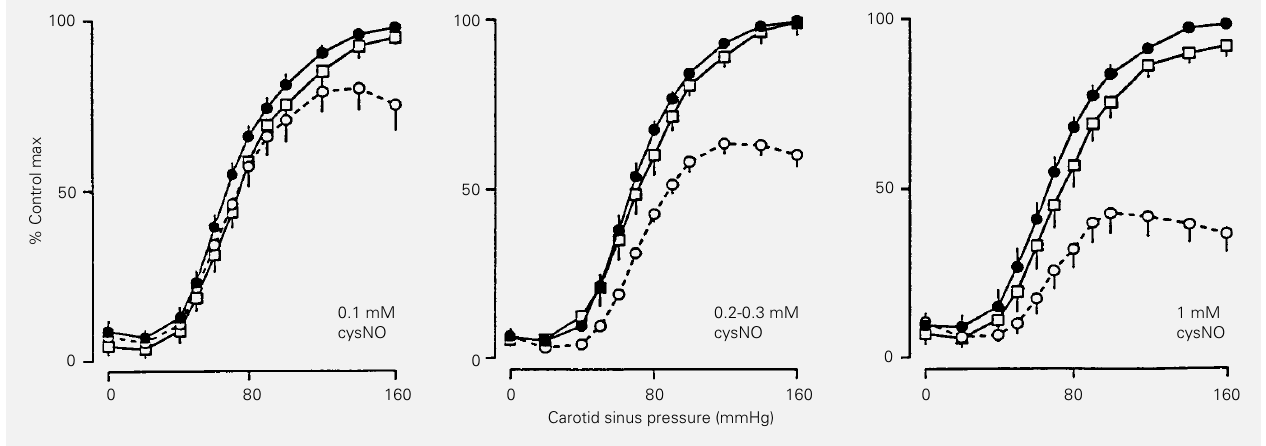
Figure 1 - Effect of S-nitrosocysteine (cysNO) on the baroreceptor activity in rabbits. Data are reported as means – SEM for 13-15 measurements. • , Control; ! , cysNO; l , recovery. Reproduced from Ref. 16, with